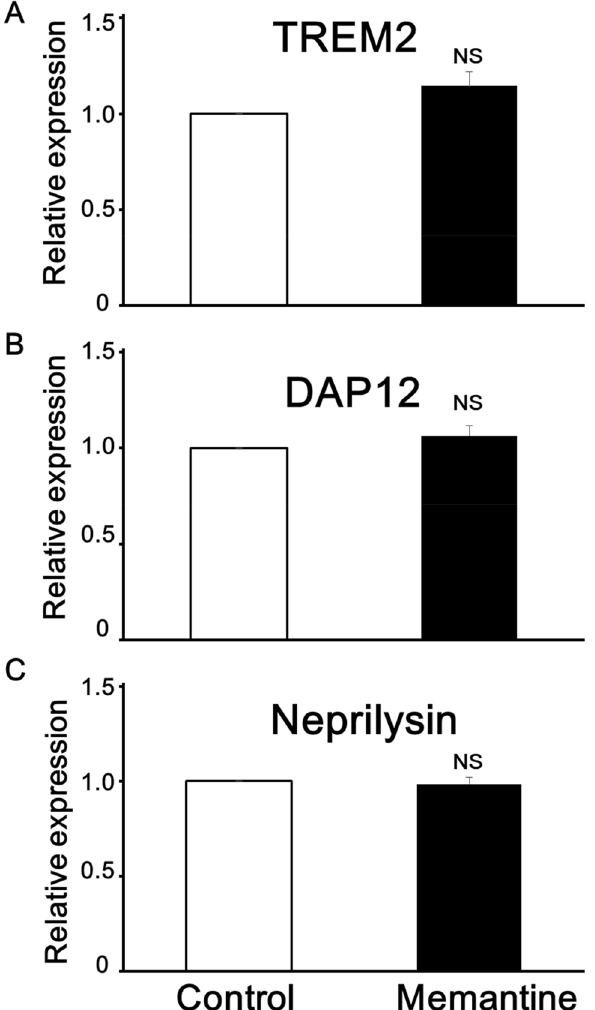
Figure 5. Effects of pretreatment with memantine on the expression of phagocytosis-related proteins in mouse 6–3 microglial cells. Bar graphs showing that pretreatment of 5 μM memantine for 12 h did not affect the amount of TREM2 ( A ), DAP12 ( B ) and neprilysin ( C ) expressed on mouse 6–3 microglial cells (n = 9 for TREM2, DAP12 and neprilysin from 9 independent experiments